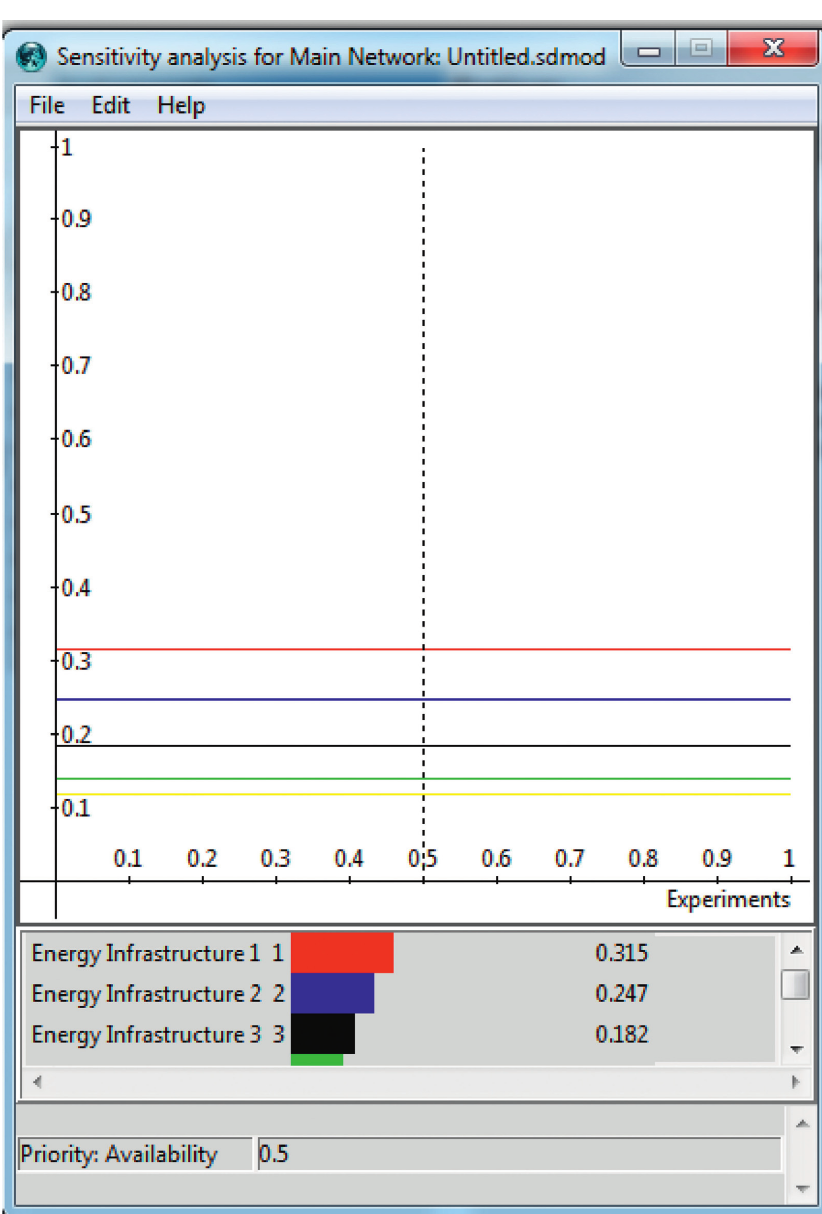
Figure 7: AHP sensitivity of the proposed